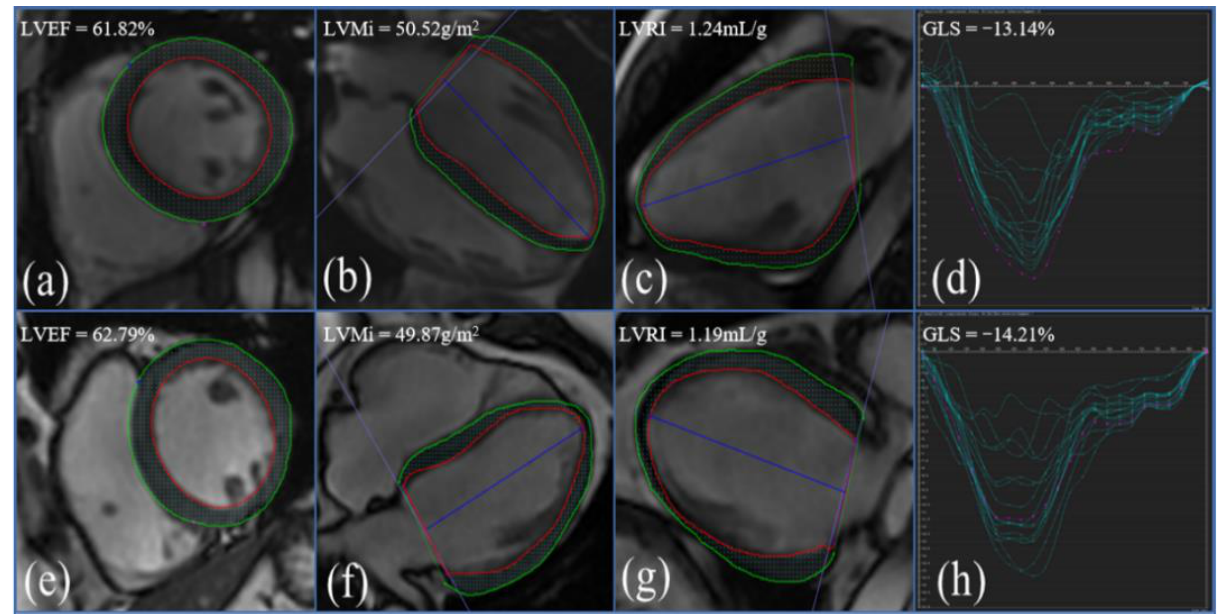
Figure 2. Left ventricular global longitudinal strain between ART-treated AIDS males and HCs. ( a – d ) AIDS, male, 27 years old. ( e – h ) HC, male, 30 years old. ( a , e ) Short axis; ( b , f ) four chamber; ( c , g ) two chamber; ( d , h ) GLS curve. Table 3. Subgroup analysis according to the CD4+ T-cell